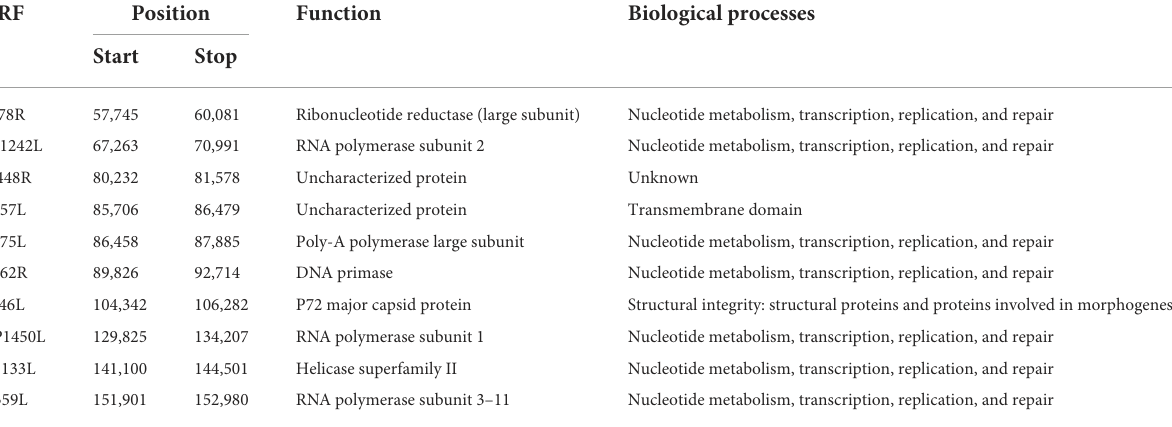
TABLE 3 Gene position, encoded protein, and biological process of the top 10 sites where the 6mA methylation was predicted (28–30). ORF Position Function Biological processes Start Stop